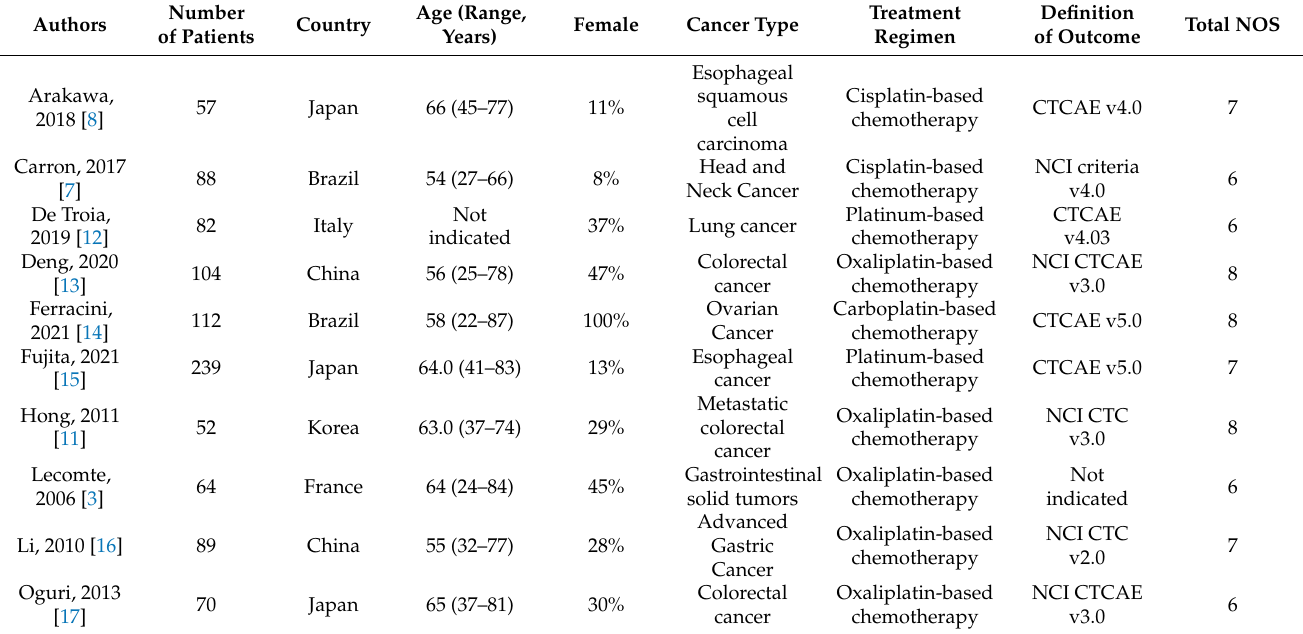
Table 1. Characteristics of studies